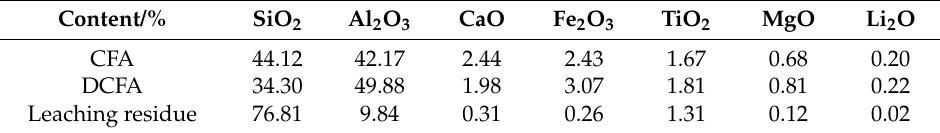
Table 4. Chemical compositions of CFA, DCFA, and the residues (mass fraction, wt %).